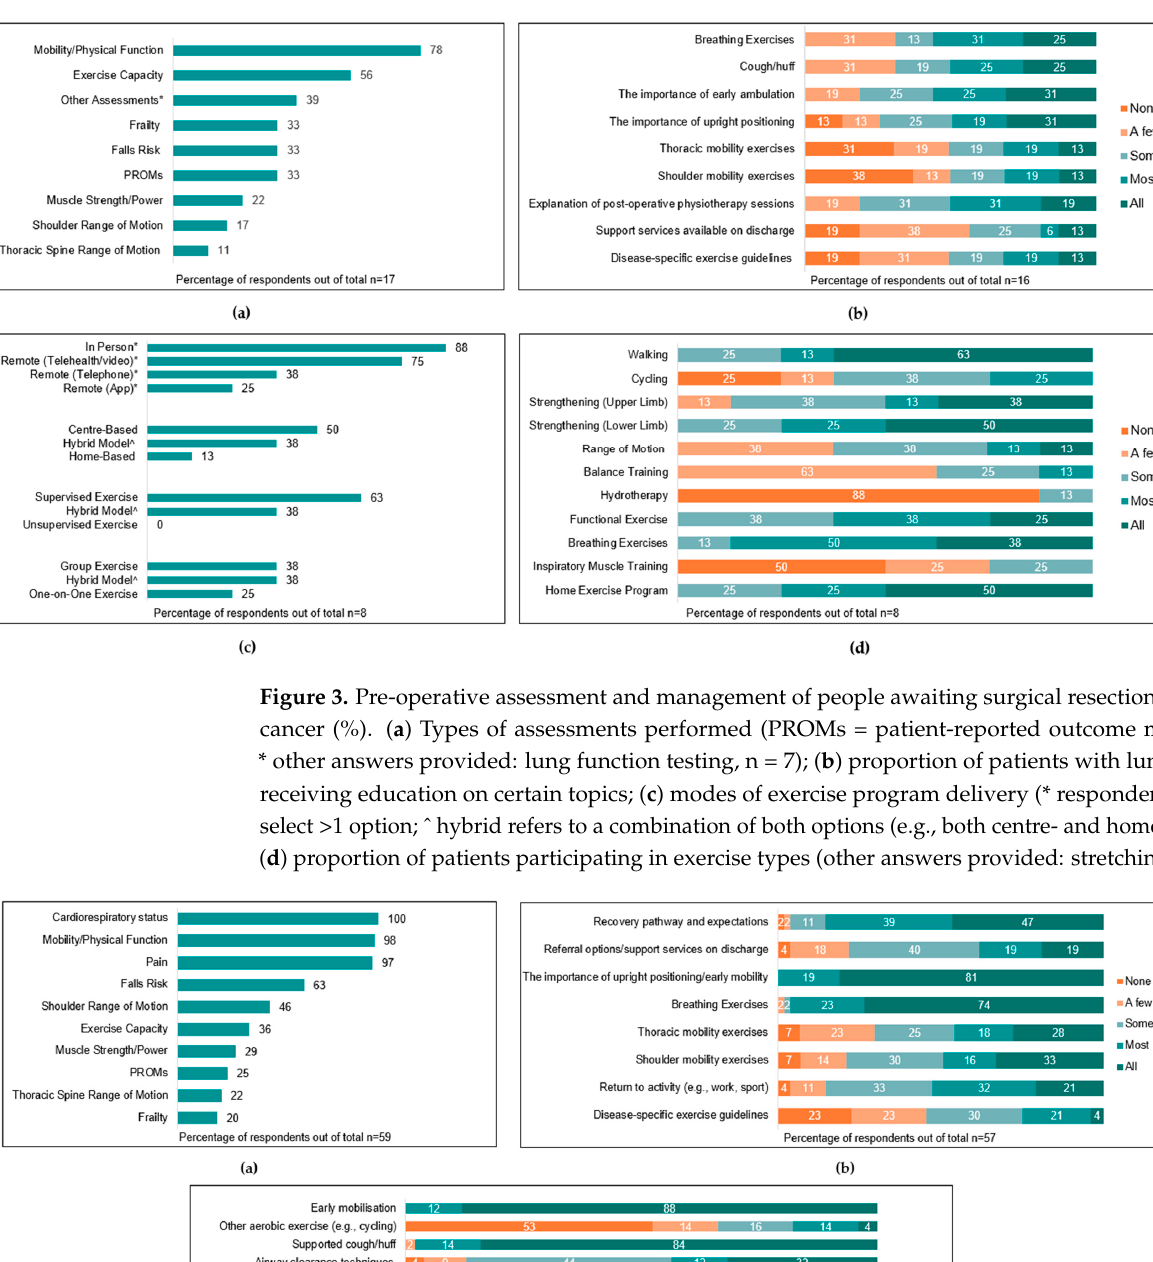
Figure 4. Inpatient post-operative assessment and management of people post surgical resection for lung cancer (%). ( a ) Types of assessments performed (PROMs= patient-reported outcome